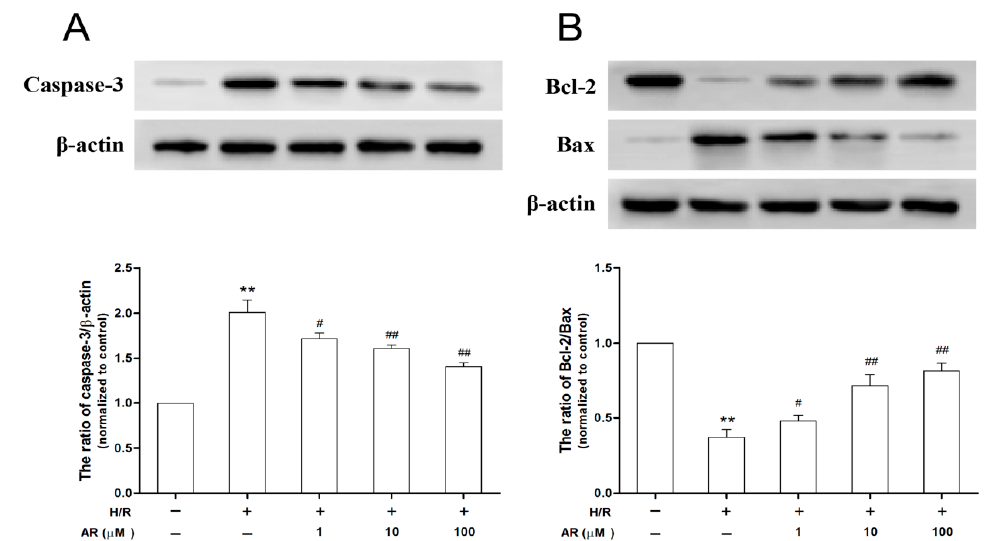
Figure 8. AR pretreatment suppressed the activity of casepase-3 and enhanced the ratio of Bcl-2 to Bax in H9c2 cardiomyocytes subjected to H/R. ( A ) Casepase-3 expression of different groups; ( B ) The ratio of Bcl-2 to Bax in various experimental treatment groups. Values presented are mean ± S.D ( n = 3). **: p < 0.01 vs. control group; # : p < 0.05 vs. H/R group; ## : p < 0.01 vs. H/R group.